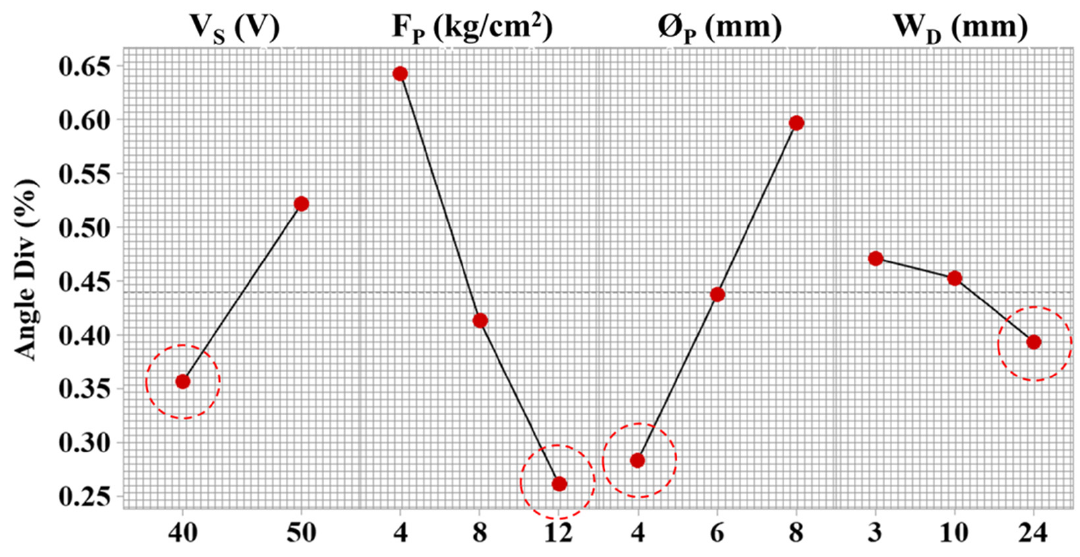
Figure 11. Parametric effects on an angular error of complex profiles machining and red circles indicating desired parametric level.